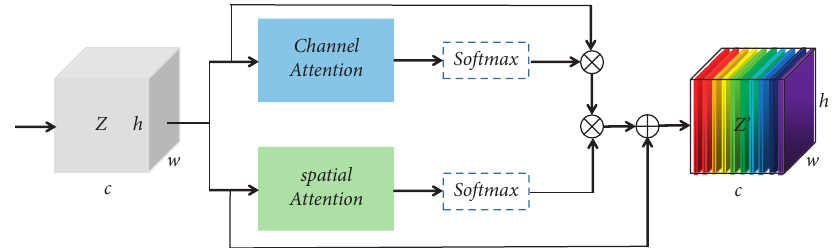
Figure 3: Proposed composite attention mechanism network